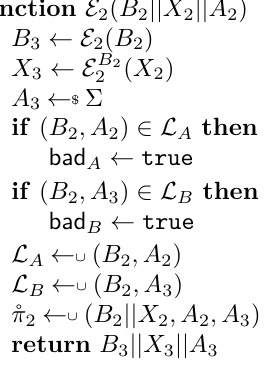
Figure 13: The function e E 2 is identical-until-bad to E 2 . As well as updating the lists L A , L B to track bad events, e E 2 must record the sampled output A 3 in ˚ π 2 in case a later (longer) query is made for which this is a